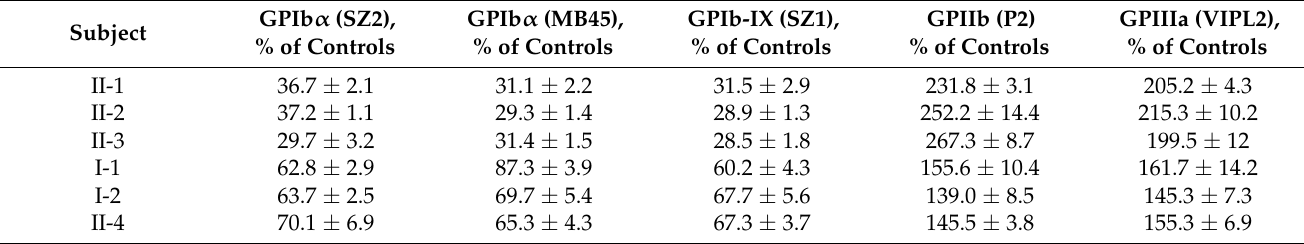
Table 2. Flow cytometry analysis of platelet surface